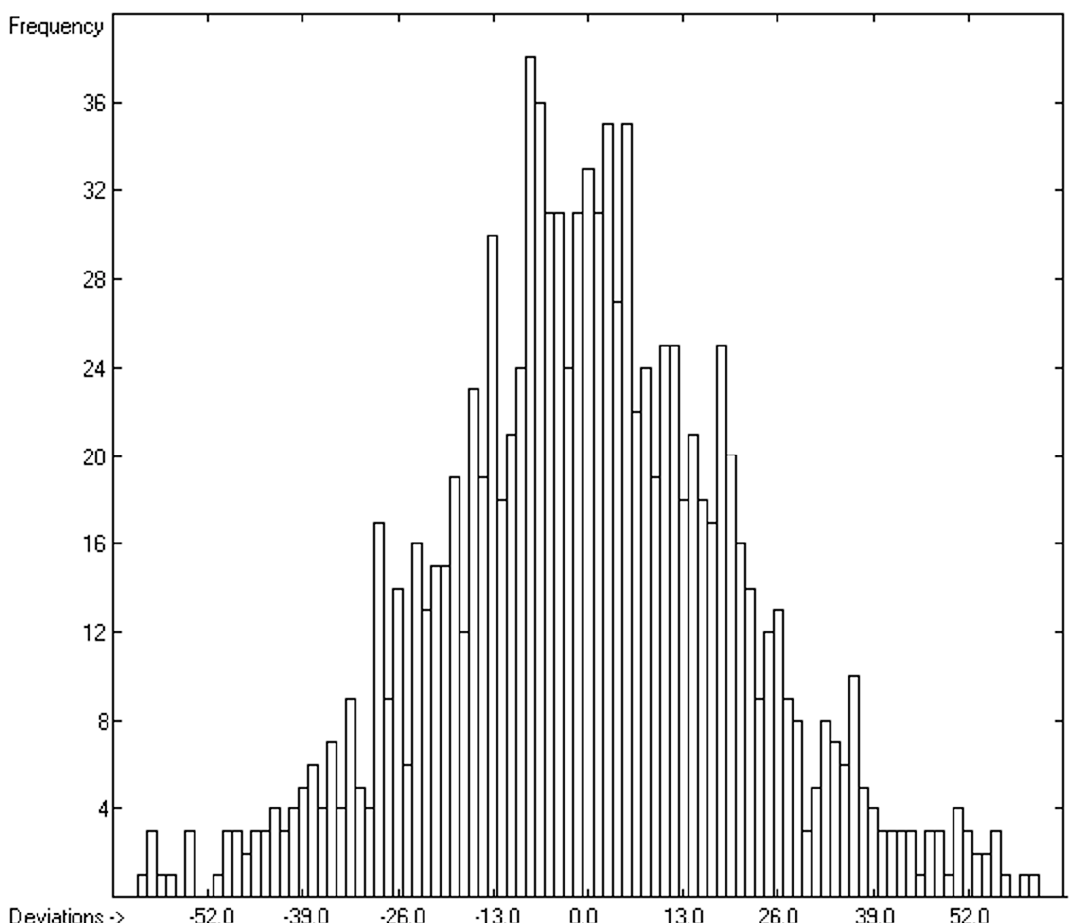
Figure 5. Histogram of molecular volumes with Cp(liq) at 298.15 K, excluding alcohols and acids. Values range from 78.7 to 1956.10 J / mol / K. Table 3. Experimental and Equation (2)-calculated Cp(liq.298) of 145 OH-free ionic liquids in J / mol /